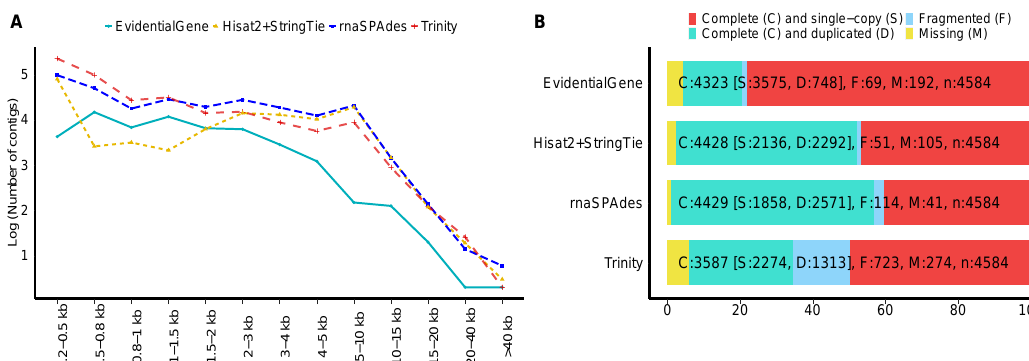
Figure 1. Contigs length distribution and assessment of transcriptomes completeness as determined by Benchmarking Universal Single-Copy Orthologous (BUSCO). ( A ), Contigs length (scaled to log10) of the different transcriptome assemblies. ( B ), BUSCO completeness for each assembly, showing the proportion (%) of complete (C) and single-copy orthologs (S), complete and duplicated (D) orthologs, missing (M) and fragmented (F) orthologs. Transcripts were queried against the Actinopterygii gene set (N = 4584). Table 2. Summary of pikeperch transcriptome assembly and assessment. Trinity